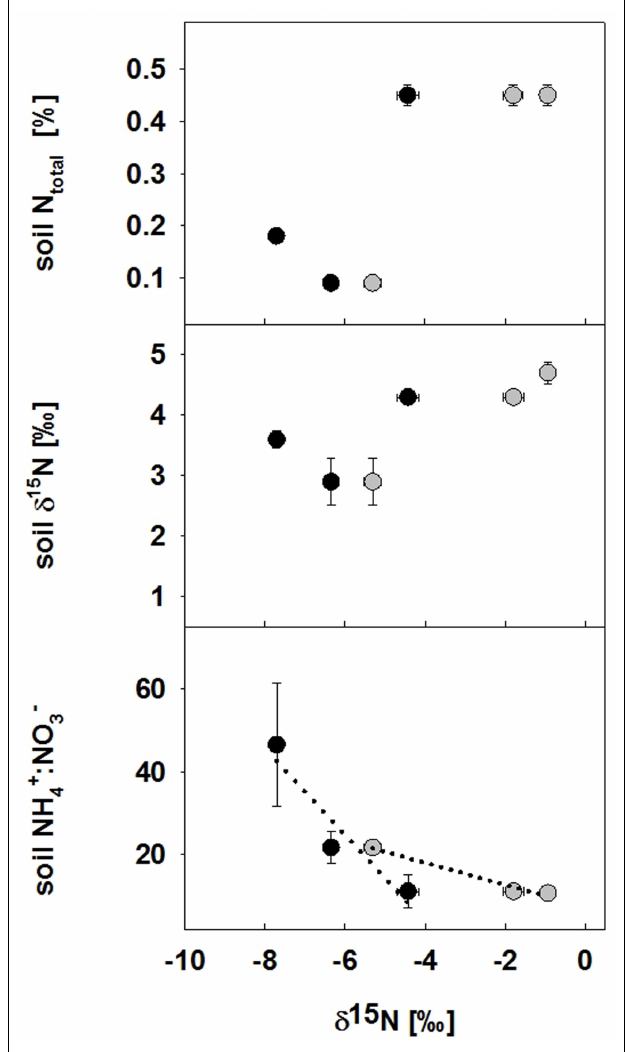
FIGURE 6 | Relationship between foliar δ 15 N of the two non-legume species (hel and gal) and abiotic aspects of the four restoration treatments. Parameters include N concentration, δ 15 N soil values and NH + : NO − ratios for bulk soil in all four restoration treatments in 2008. 4 3 Tentative correlations are shown as dotted lines.Values are means ± 1 SEM and each symbol represents the δ 15 N value of a species (without separation into different legume neighborhoods) in one of the four restoration treatments (note that hel was not present in the control treatment, and gal was not present in the topsoil and hay addition treatment); black symbols ( • ) represent hel ( Helianthemum nummularium) , gray symbols ( • ) gal ( Galium mollugo)